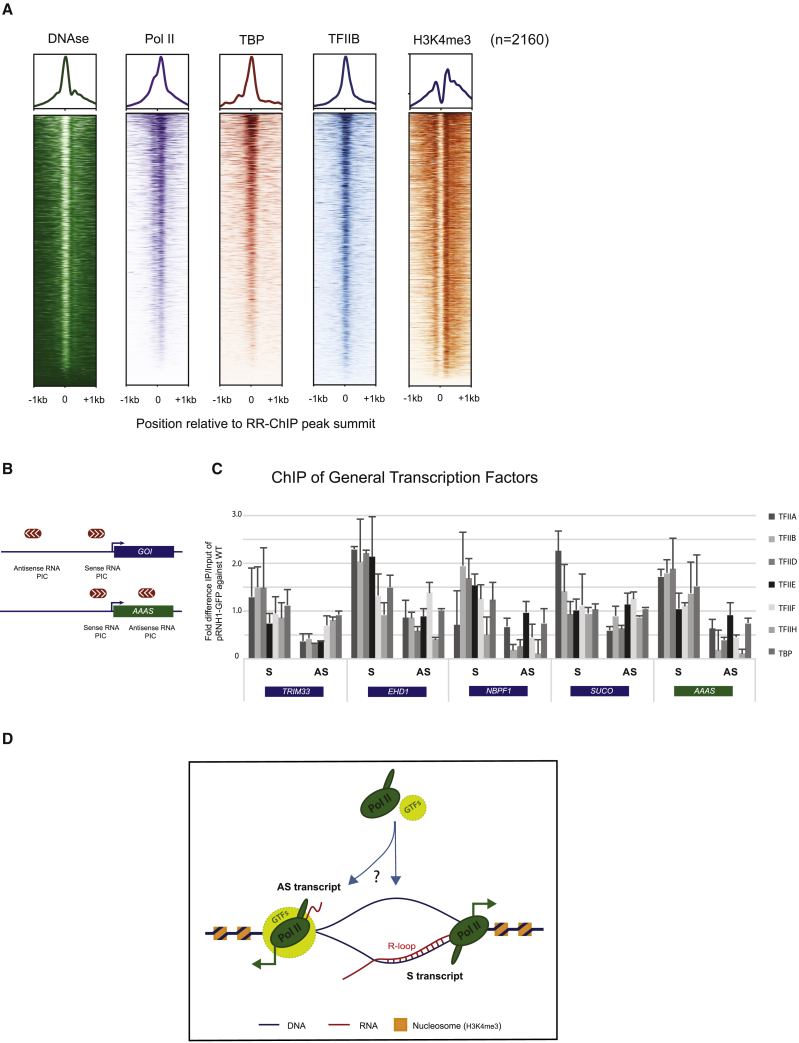
Preinitiation Complexes on R-Loop Promoters(A) Heatmap of RR-ChIP-seq signal density using k-means clustering showing correlation of RR-ChIP-seq peaks in a ±1 kb window with DNase-seq, Pol II, TBP, TFIIB ChIP-seq, and H3K4me3 mNuc-seq datasets.(B) Schematic of PIC positions with respect to protein-coding gene TSS. GOI, gene of interest.(C) qPCR quantification of ChIP signal for GTFs over regions as in (B). Data represented as mean ± SEM (n = 3).(D) Model: Pol II and GTFs are recruited to R-loop regions through direct or indirect effects of ssDNA displaced by formation of RNA:DNA hybrid between S transcript and template DNA strand over the promoter. This will lead to synthesis of an antisense (AS) transcript through recruitment of an AS PIC either to the ssDNA or adjacent DNA. Positions of H3K4me3 nucleosomes that define bidirectional PICs are indicated.